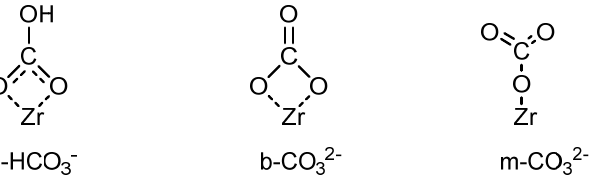
Figure 4. Reaction species involved using ZrO 2 catalyst for DMC synthesis, as proposed by Akune et al. [33]. (Reprinted/adapted with permission from Ref. [33], 2018, ACS)